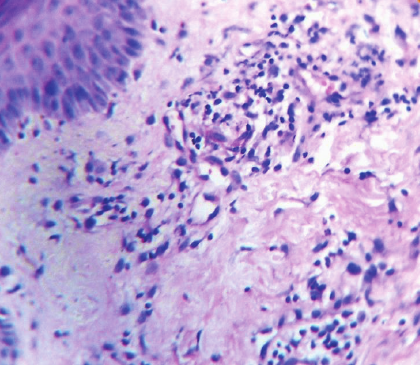
Figure 2: Multiple furuncles and acneiform lesions over back.